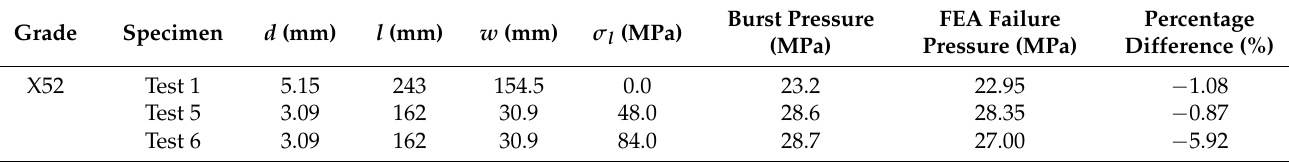
Table 6. FEM failure pressure validation against full scale burst tests by Bjorney et al. for single corrosion defect [55]. Grade Specimen